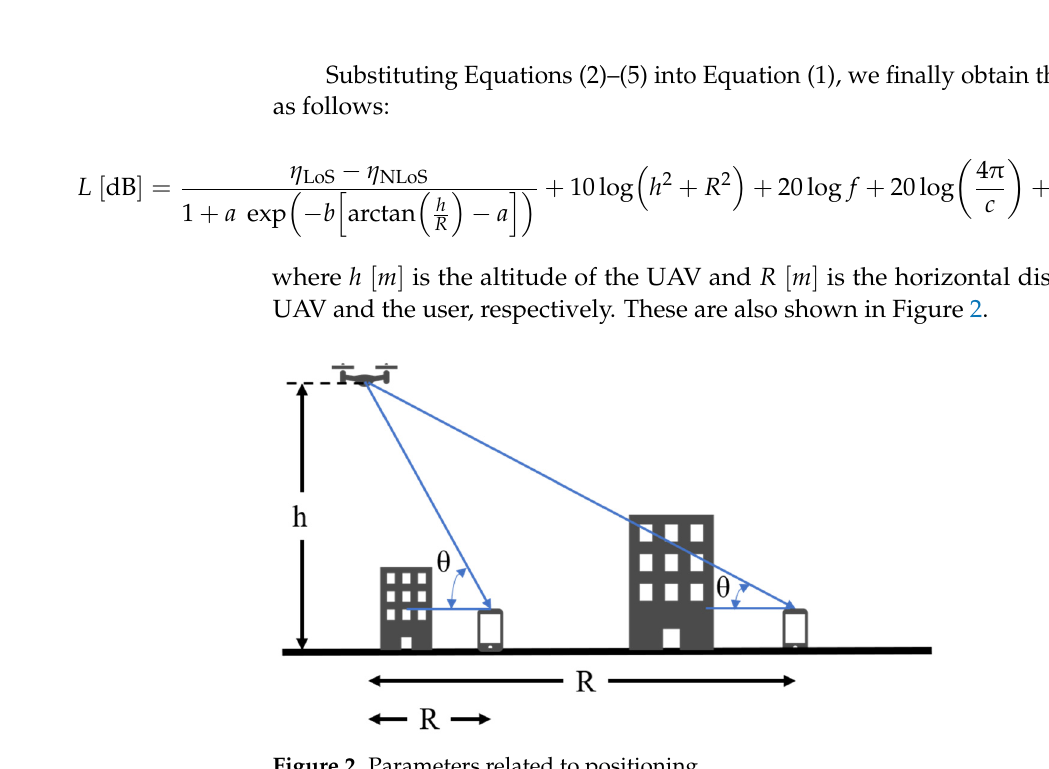
Figure 2. Parameters related to positioning.